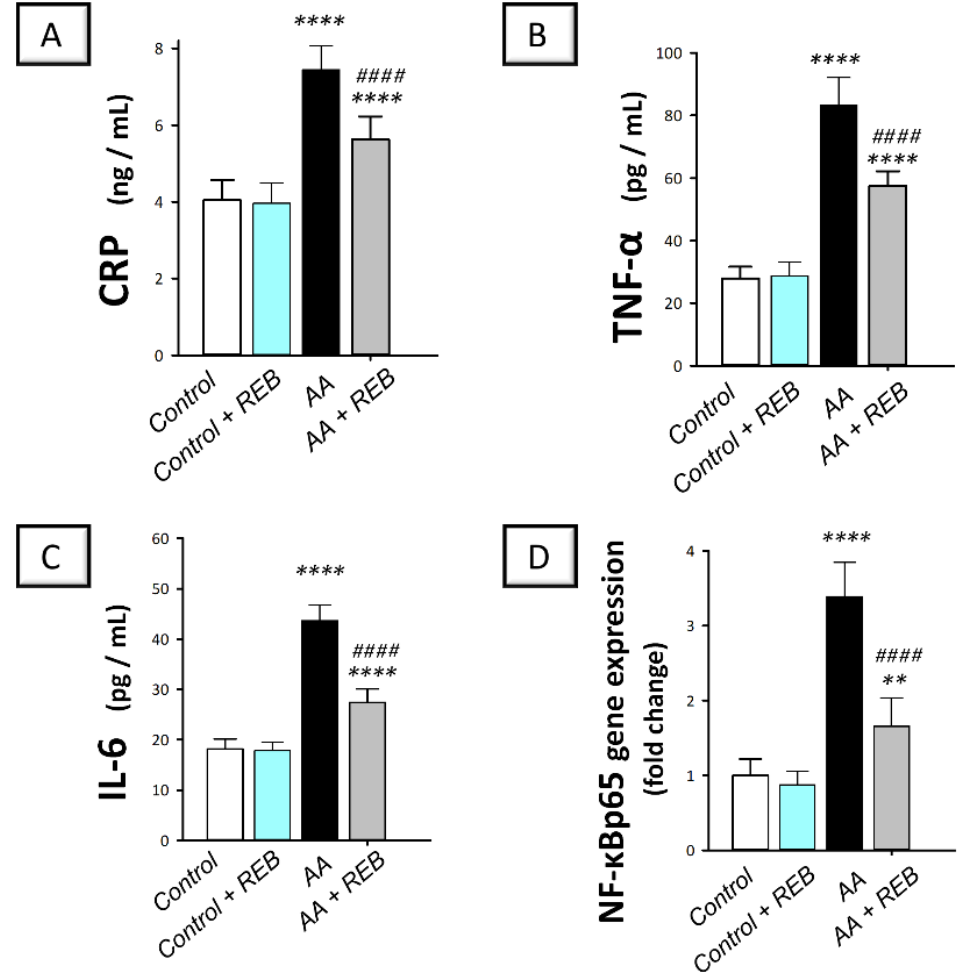
Figure 4. Rebamipide inhibits the pro-inflammatory signals in rats exposed to acetic acid-induced colitis. ( A ) Serum C-reactive protein (CRP) levels. ( B ) Serum tumor necrosis factor-alpha (TNF-α) levels. ( C ) Serum interleukin-6 (IL-6) levels. ( D ) The gene expression levels of the nuclear factor kappa B (NF-κBp65) in the colonic tissue. Each bar represents the mean ± S.D. ( n = 7–8). A one-way